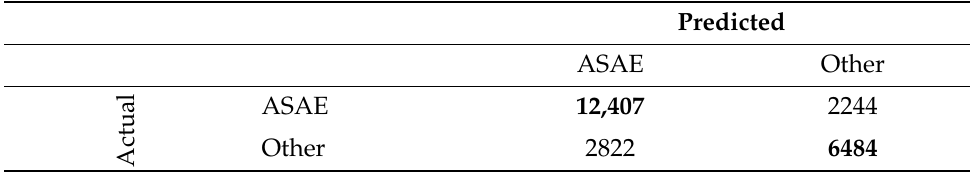
Table 10. Competence prediction confusion matrix using SVM.